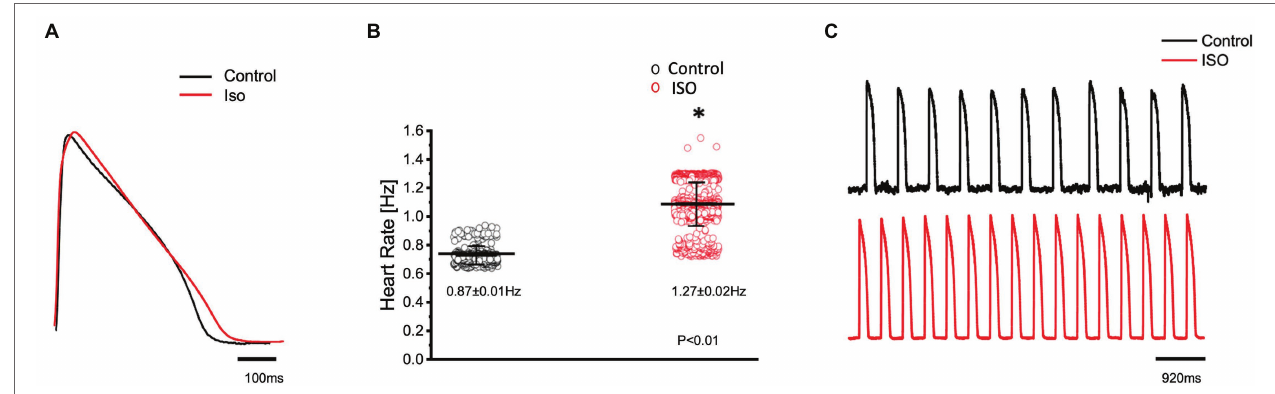
FIGURE 1 | Goldfish ventricular action potential and spontaneous heart rate recordings before (black) and after perfusion with 100 nm isoproterenol (red). Perfusion of the Goldfish intact heart with 100 nm isoproterenol altered the action potential morphology (A) and had a positive chronotropic effect, significantly increasing the heart rate ( B ; from 0.87 ± 0.01 Hz to 1.27 ± 0.02 Hz, p < 0.01, n = 160 for the control, n = 263 for ISO, N = 4). The positive chronotropic effect following isoproterenol perfusion is also reflected in spontaneous AP recordings from the left ventricle (C) . * Denotes a significant difference between the two distributions. The data are presented as multiple measurements (n; dot cloud) recorded for different measurements ( n ) on different hearts ( N ) with the mean ± SEM (solid